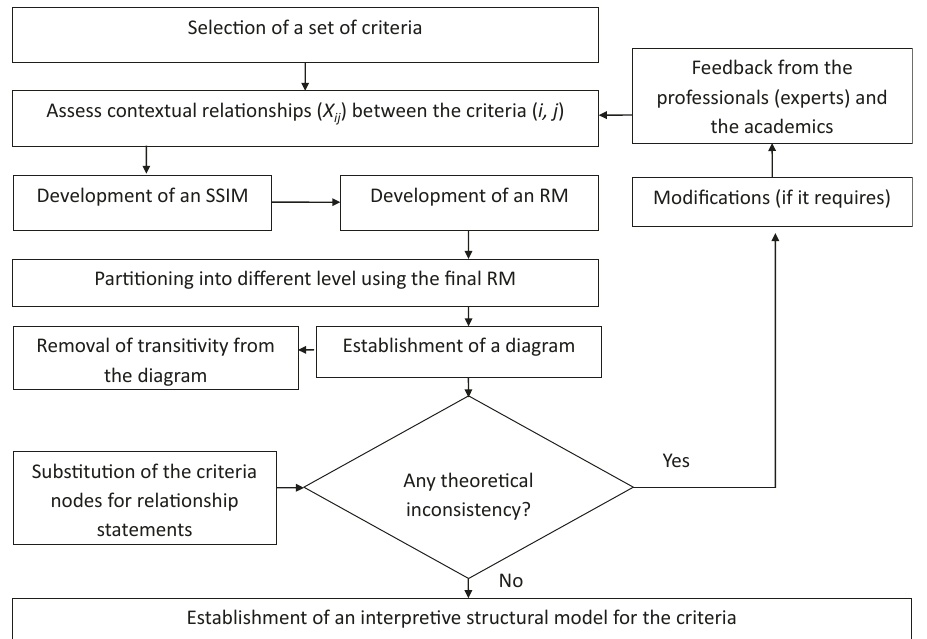
Fig. 4 ISM method. A fl owchart of the interpretive structural modelling method that applied to establish an ISM model of the procurement challenges.